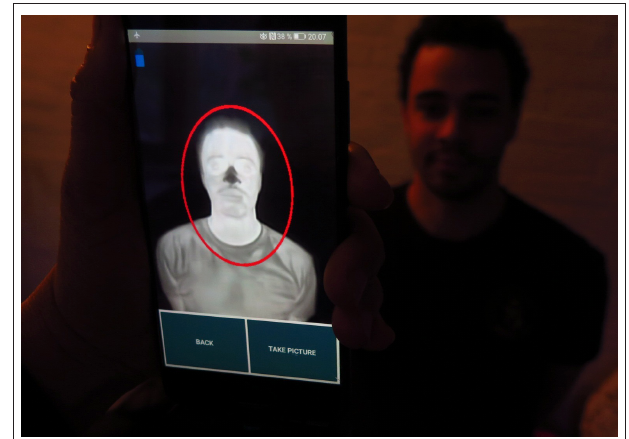
FIGURE 5 | Idea behind the CNN